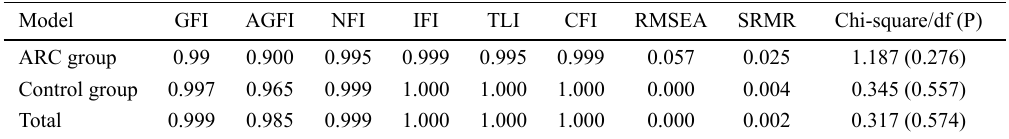
Table 4. Model goodness of fit index.